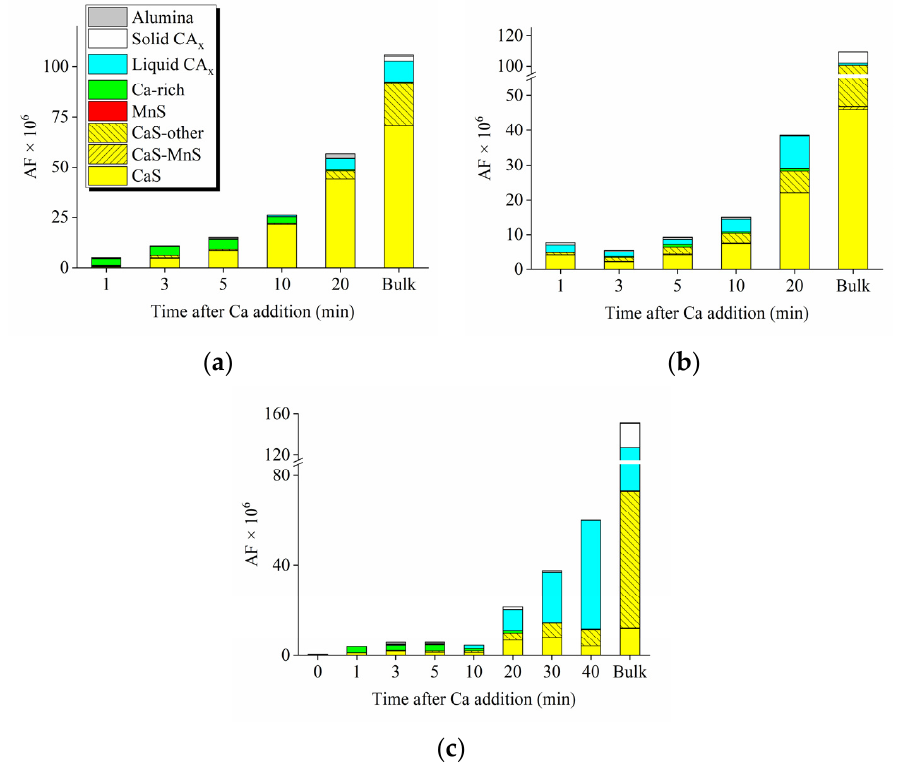
Figure 3. Evolution of area fraction (AF) of inclusions in ( a ) Exp. 2035, ( b ) Exp. 3035, and ( c ) Exp. 2025.